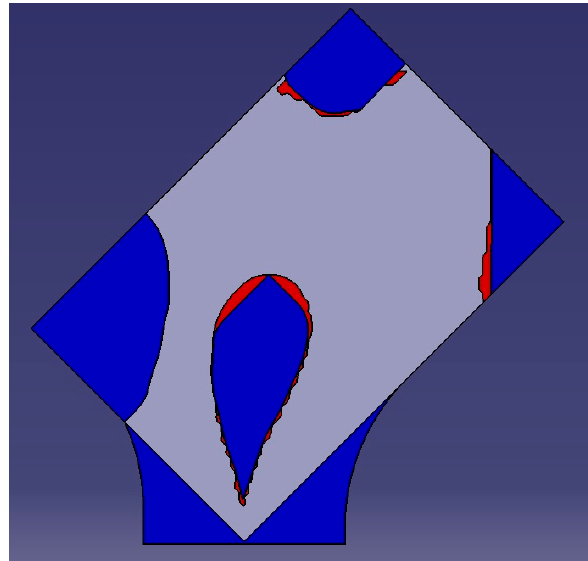
Figure 15. AM shaped part compared to TO using SIMP.